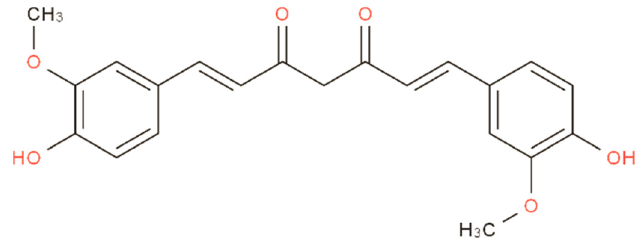
Figure 1. Chemical structure diagram of curcumin.